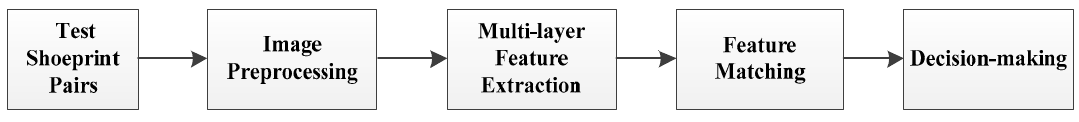
Figure 4. Framework of the proposed shoeprint verification system.